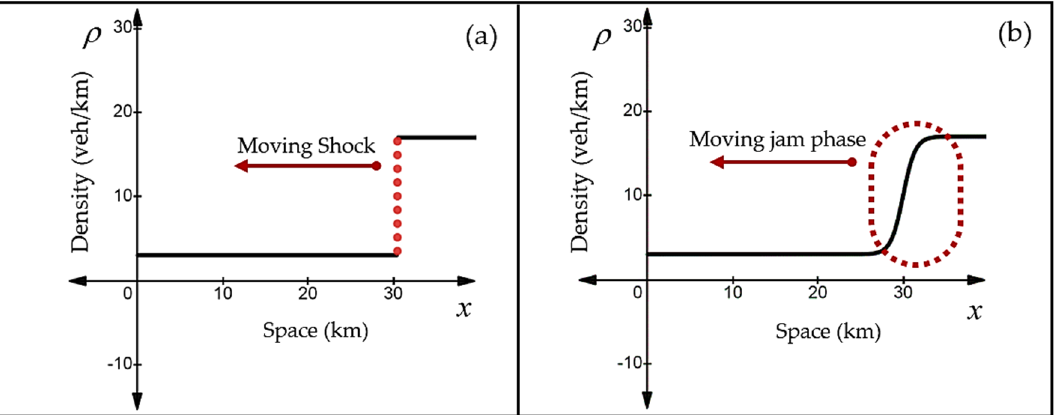
Figure 1. Moving jam: ( a ) Discontinuous moving jam due to infinite deceleration; ( b ) smooth moving jam phase due to gradual deceleration.